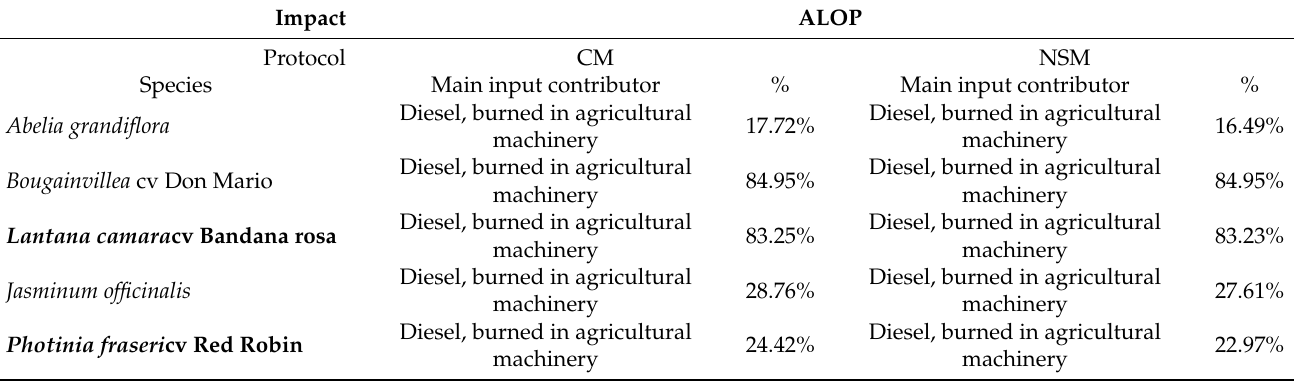
Table A5. Inputs’ contribution to input categories associated with CM and NSM ornamental produc- tion models of 1000